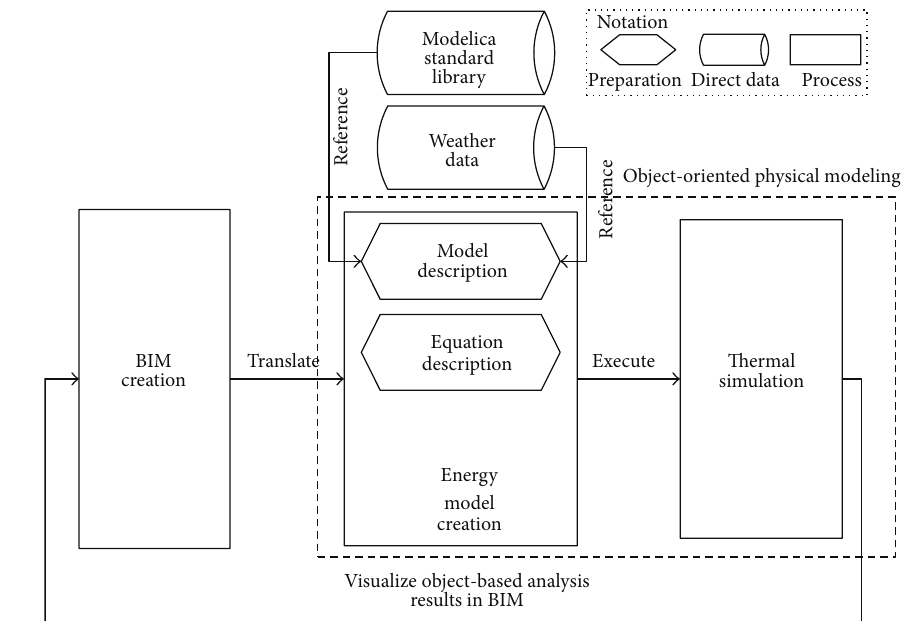
Figure 1: The overall translation process between BIM and ModelicaBEM